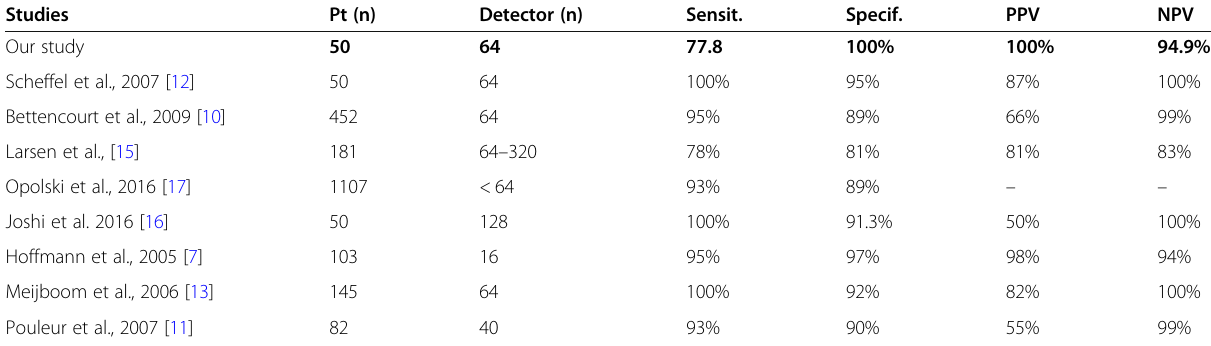
Table 5 The different study results of CCTA accuracy for the detection of significant coronary lesions ≥ 50% compared to our study